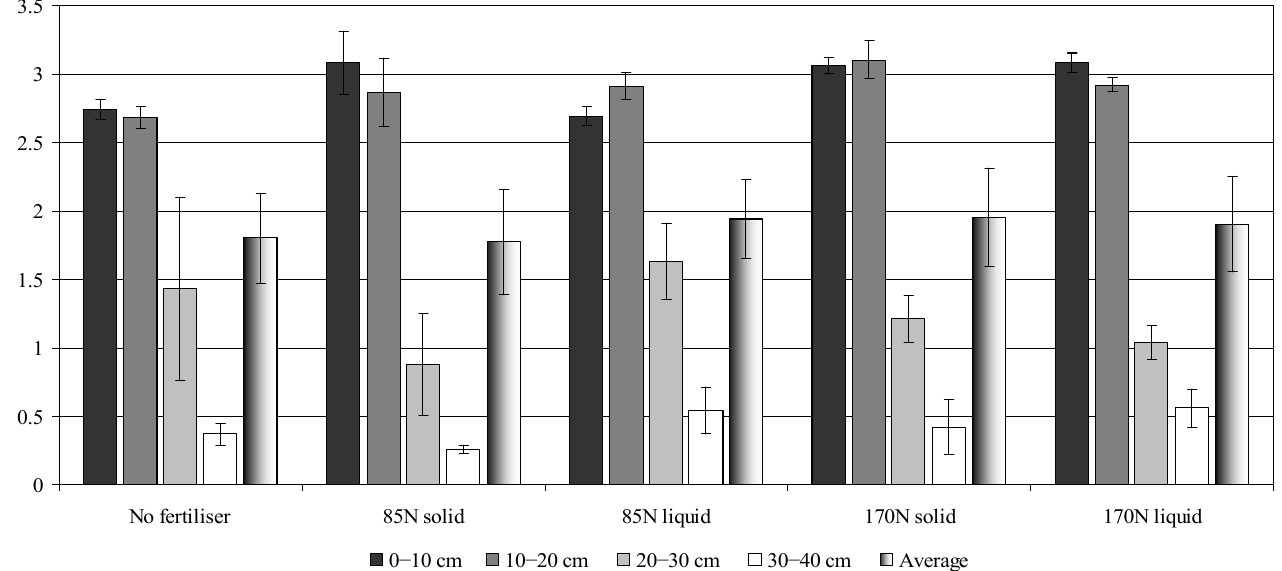
Figure 8. MHS content in the crop rotation field in Fluvisol, 2019.